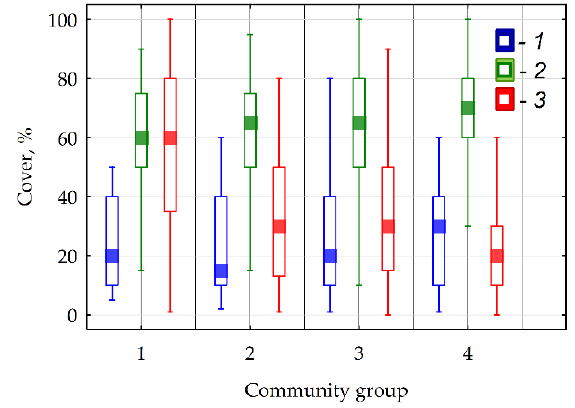
Figure 7. Cover of understorey in spruce and spruce–aspen / birch communities: 1 —shrub layer, 2 —warf shrub–herb layer and 3— moss layer. Community groups: 1—DShG, 2—Sh; 3—ShBh and 4—Bh. Box-whisker type: median / 25 and 75 percentiles / nonoutlier range.